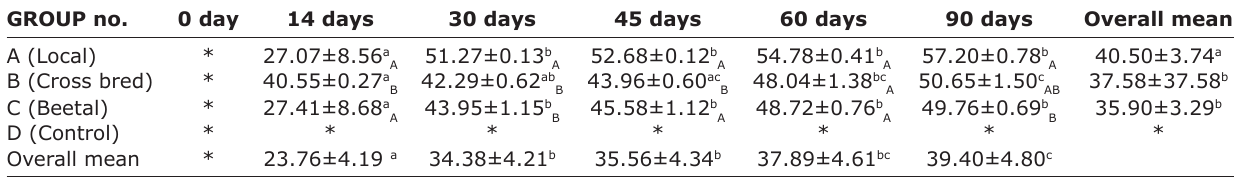
Table-1: Mean±SE of serum antibody titer of vaccinated and control group of goats. GROUP